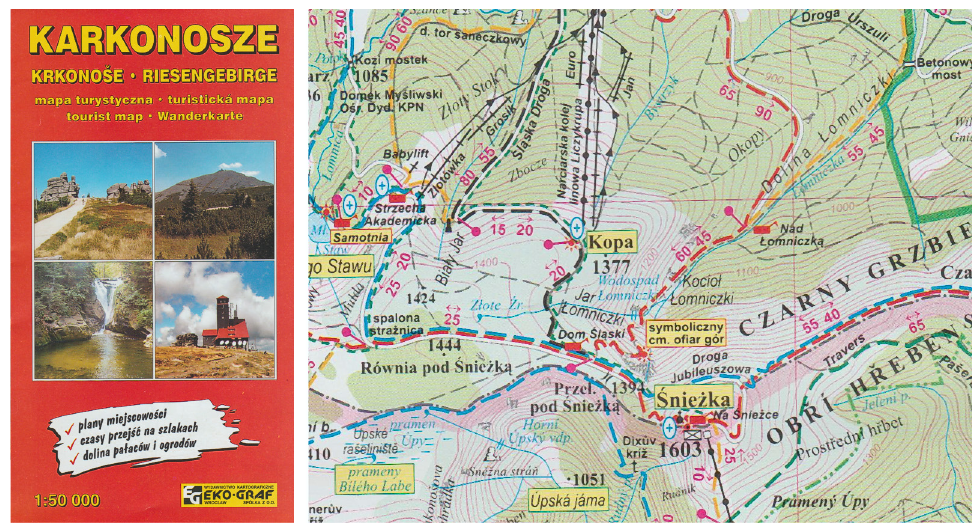
Fig. 1. Karkonosze. Mapa turystyczna (Karkonosze. Tourist map) 1:50 000. Wrocław: Wydawnictwo Kartograficzne Eko-Graf,